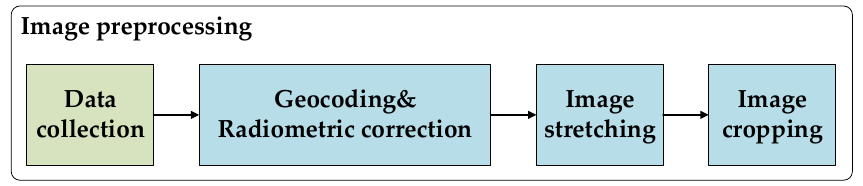
Figure 2. The process of image preprocessing.